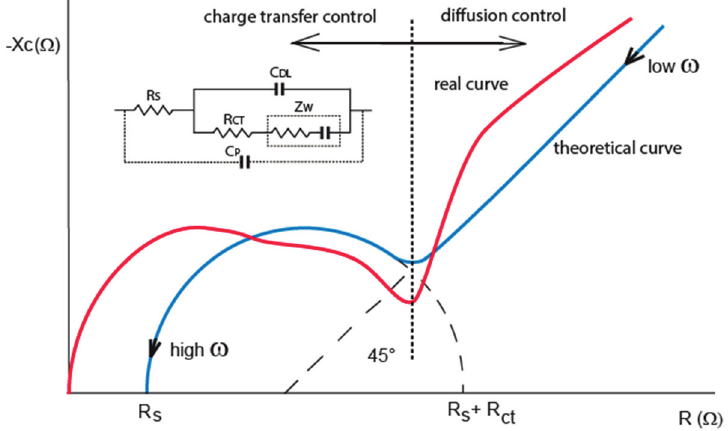
Figure 1. Nyquist plots of interface impedance, theoretical locus (blue curve) and real locus (red curve). The real locus shows parasitic capacitance overlapping double layer capacitance. Randles equivalent circuit is drawn in the inset of graph. Additional parasitic capacitance is involved for real behavior circuit of interdigitated electrodes